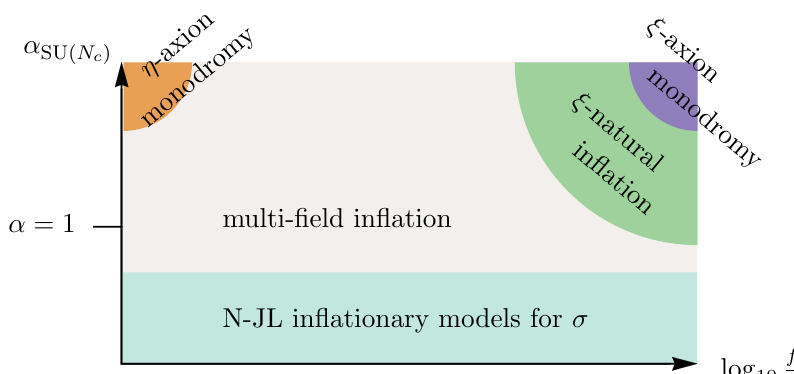
Figure 16 . Schematic phase diagram for in(cid:13)ationary models arising as infra-red theories from the string inspired action